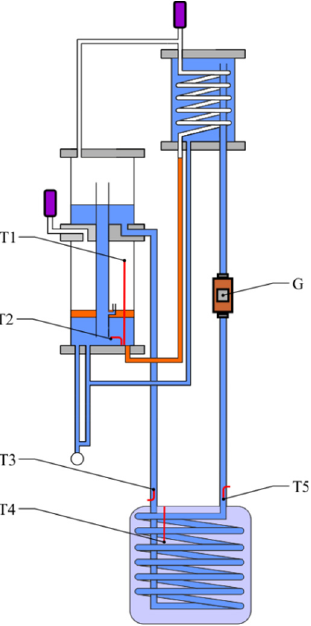
Figure 10. Location of measuring sensors: T1–T5—temperature sensors; G—flow sensor. All physical parameters were measured and registered at a frequency of 1 Hz.